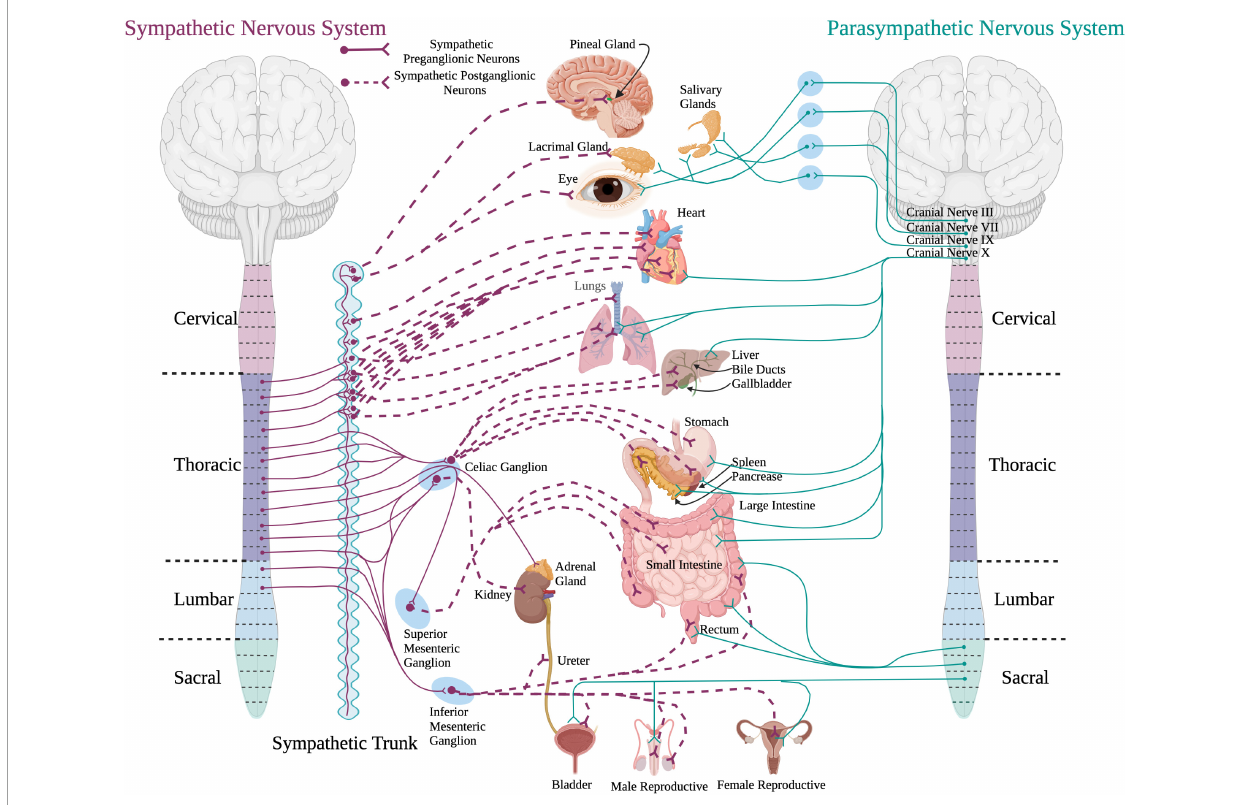
FIGURE1 A schematic of the sympathetic and parasympathetic innervation to peripheral organs. Sympathetic preganglionic neurons reside in the intermediolateral cell column in the thoracolumbar spinal cord and project out to and synapse upon sympathetic postganglionic neurons within the sympathetic chain. The sympathetic postganglionic neurons innervate target organs in the periphery. For the parasympathetic system, preganglionic neurons residing in the brainstem and sacral spinal cord send projections directly to target organs in the periphery. (Created using